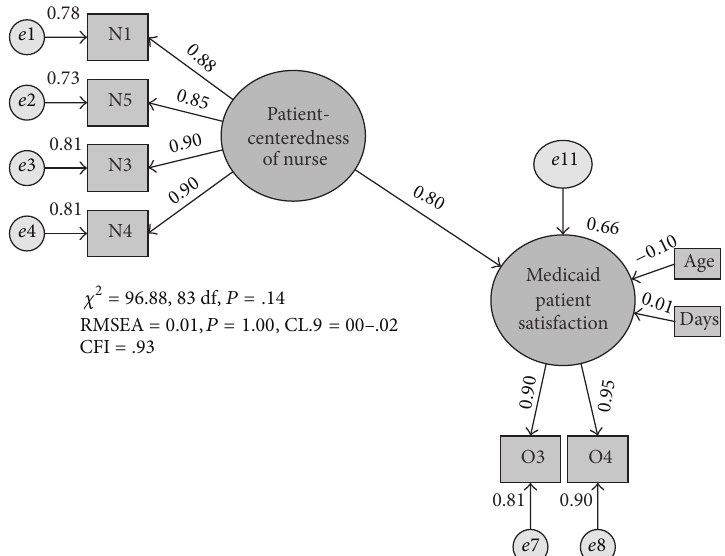
Figure 4: Standardized effects. (All paths in the model statistically significant at the 𝑃 < 0.001 level, except for the paths between age and patient satisfaction and between days (i.e., length of stay) and patient satisfaction ( 𝑃 > 0 .05 for both